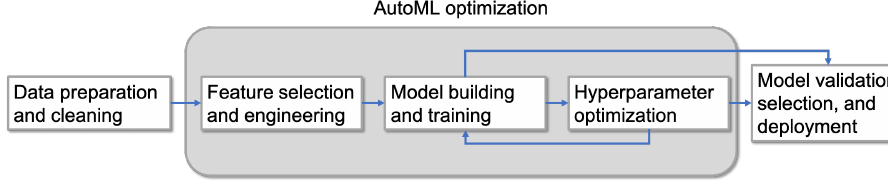
Figure 4. Important components and process of a machine learning problem